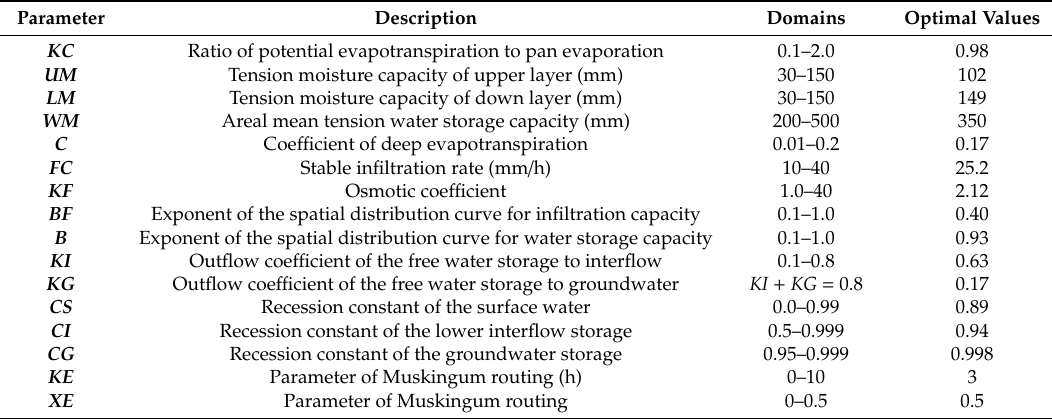
Table A1. Parameters of the proposed model along with their descriptions and ranges for Zijingguan Basin.